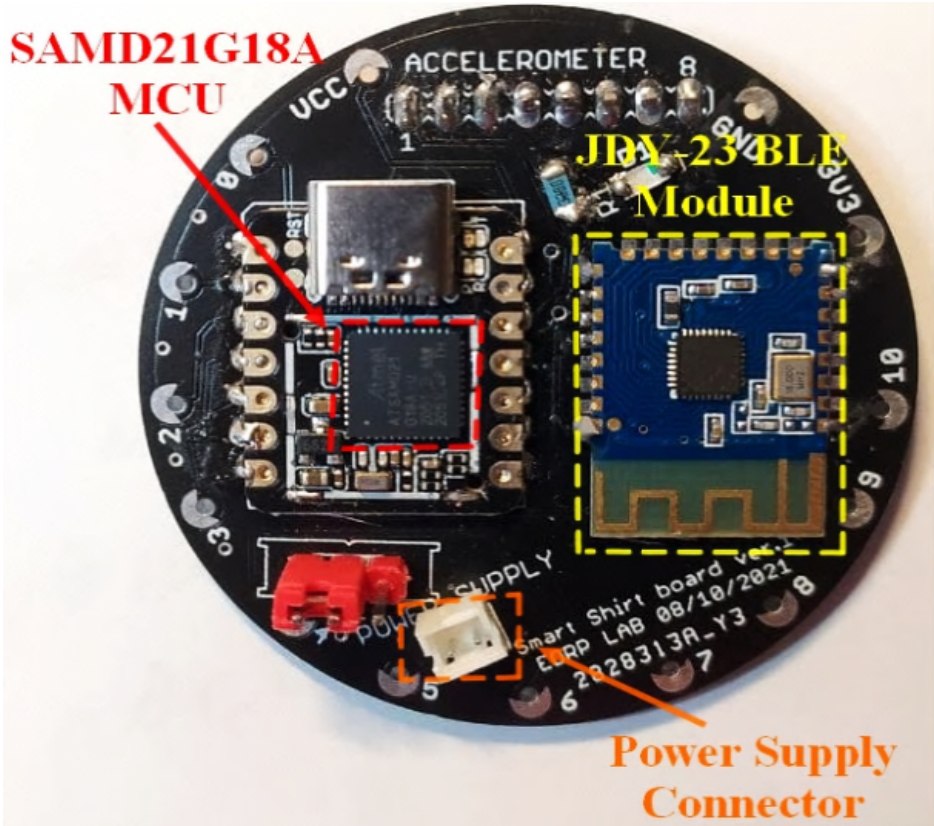
Figure 2. Top view of the custom microcontroller board integrated into the smart garment.